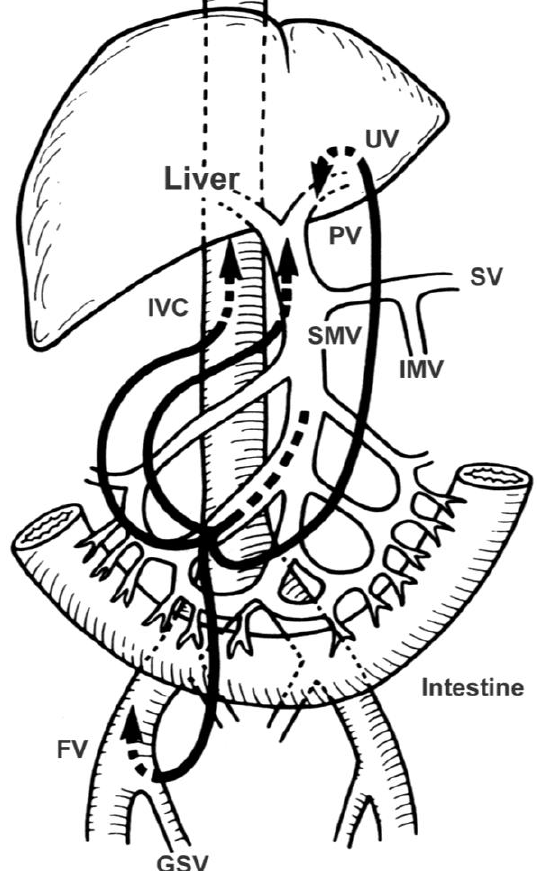
Figure 2. Procedures for bypassing the portal vein. UV, umbilical vein; PV, portal vein; SV, splenic vein; SMV, superior mesenteric vein; IVC, inferior vena cava, IMV, inferior mesenteric vein; FV, femoral vein; GSV, greater saphenous vein.